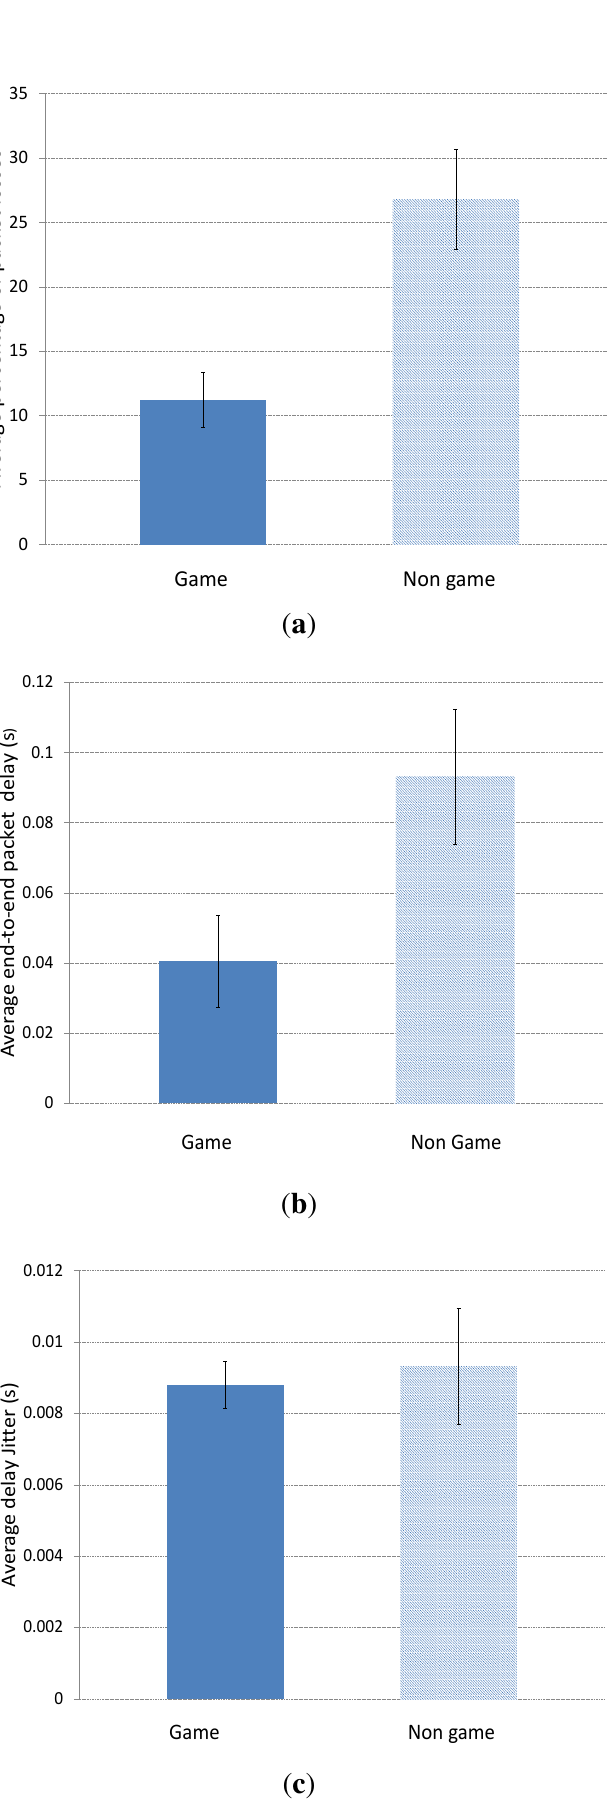
Figure 19. Simulation results for N = 2 users. (a) Average percentage of packet losses; (b) Average end-to-end packet delay; (c) Average delay